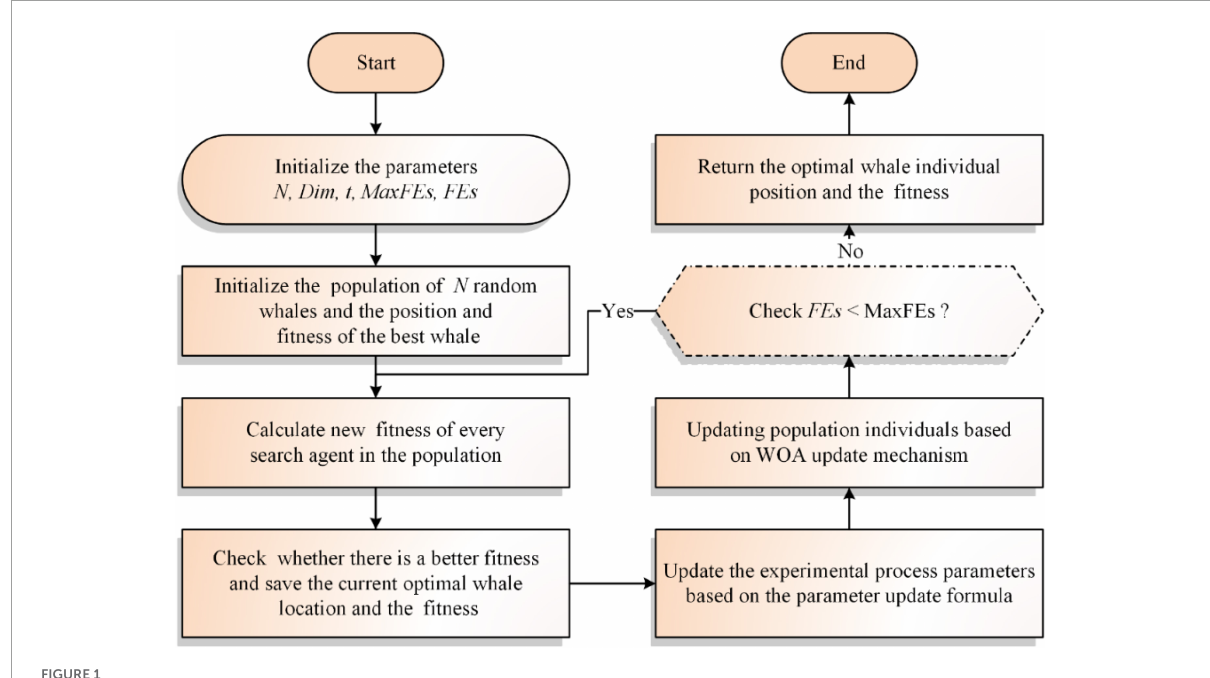
FIGURE1 Flowchart of the traditional